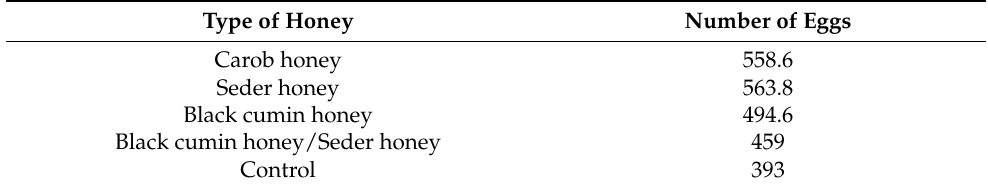
Table 5. The impact of three types of honey on the number of deposited eggs of Bombyx mori